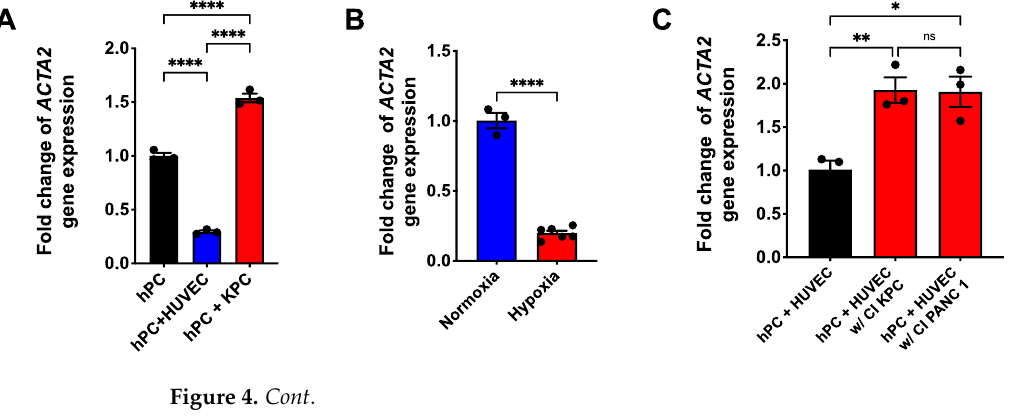
Figure 4. Pericytes ’ phenotype is influenced by pancreatic cancer cells. ( A – C ) Quantification of ACTA2 expression when pericytes are cultured in various conditions. ( A ) hPC was culture alone, with hEC (HUVEC), or KPC 689 cancer cells. ( B ) hPC was cultured in either a normoxic or hypoxic condition. ( C ) hPC and hEC were co-cultured at the bottom of a culture insert, and cancer cells (KPC or PANC-1) were cultured on the culture insert. ( D , E ) Either hPC alone or a hPC + hEC co-culture was treated with PBS, HPNE Exo or PANC-1 Exo. ACTA2 ( D ) and DES ( E ) expression levels were